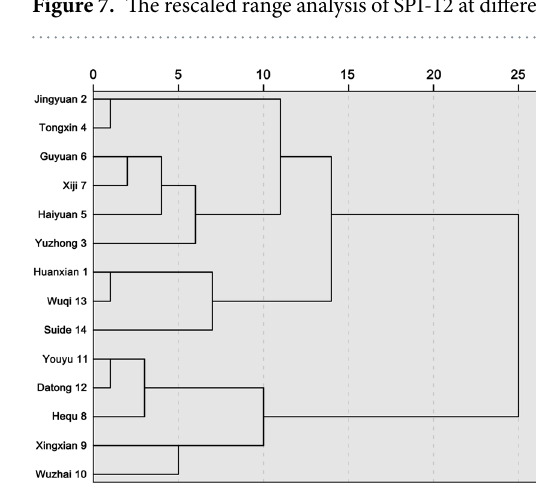
where n is the sample size. For the lag-1 serial correlation coefficient ( r 1 ) of the detrended series ′ X by Eq. (10), the sample data are considered to be serially independent. In this case, linear trend estimation,